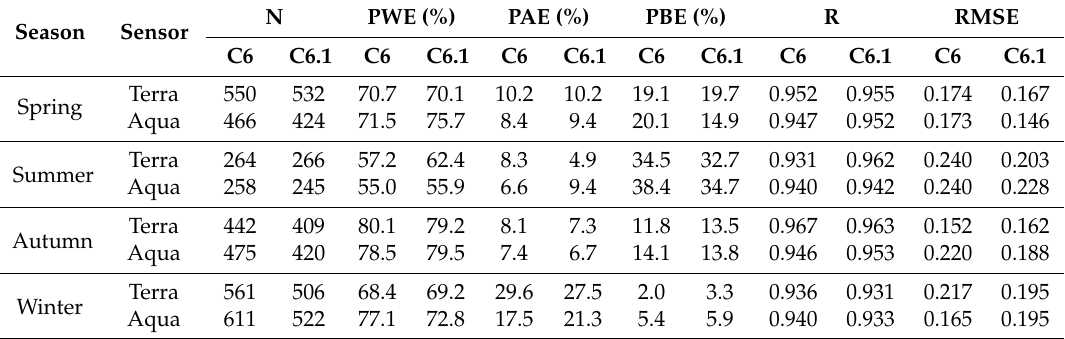
Table 2. Comparison of the retrieval accuracy between the MOD04/MYD04 C6 DB and C6.1 DB AOD products in the four